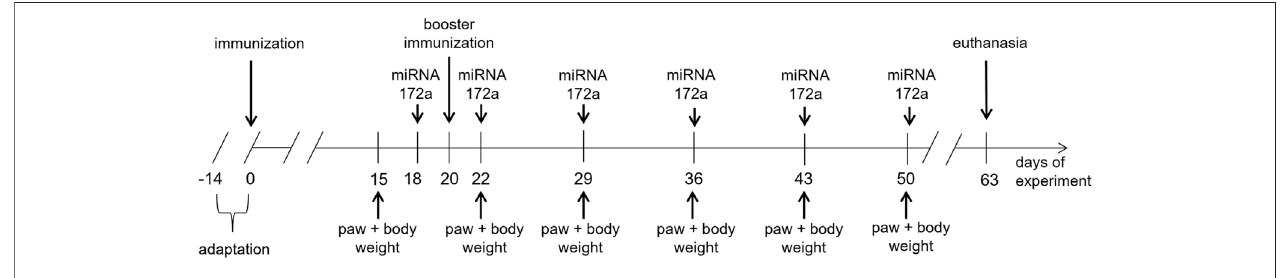
FIGURE 1 | Design of the experiment with the use of an animal model of RA –